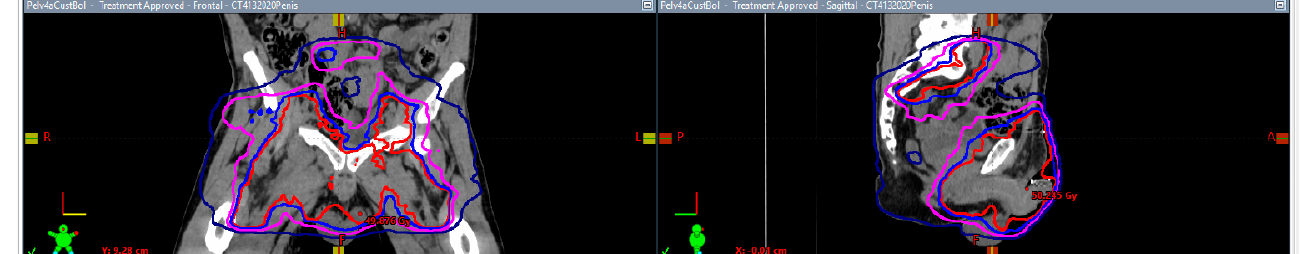
Figure 4. Axial, coronal, and sagittal isodose displays of initial pelvic radiotherapy plan to 45 Gy in 25 fractions. Lines in red, blue, magenta, and navy correspond with 45 Gray (Gy), 42.75 Gy, 36 Gy, and 22.5 Gy, respectively.